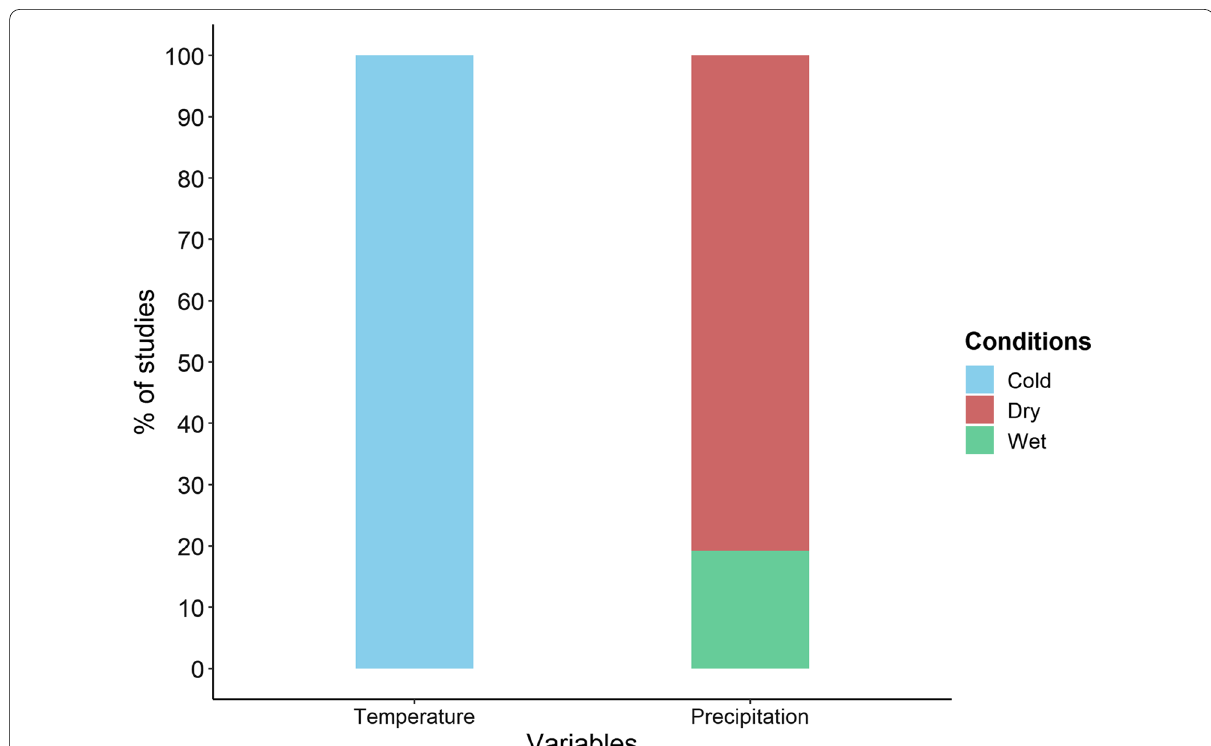
Fig. 3 Relationship of temperature and precipitation during the LGM. The number of studies used for the warm/cold or wet/dry conditions can be found in Table